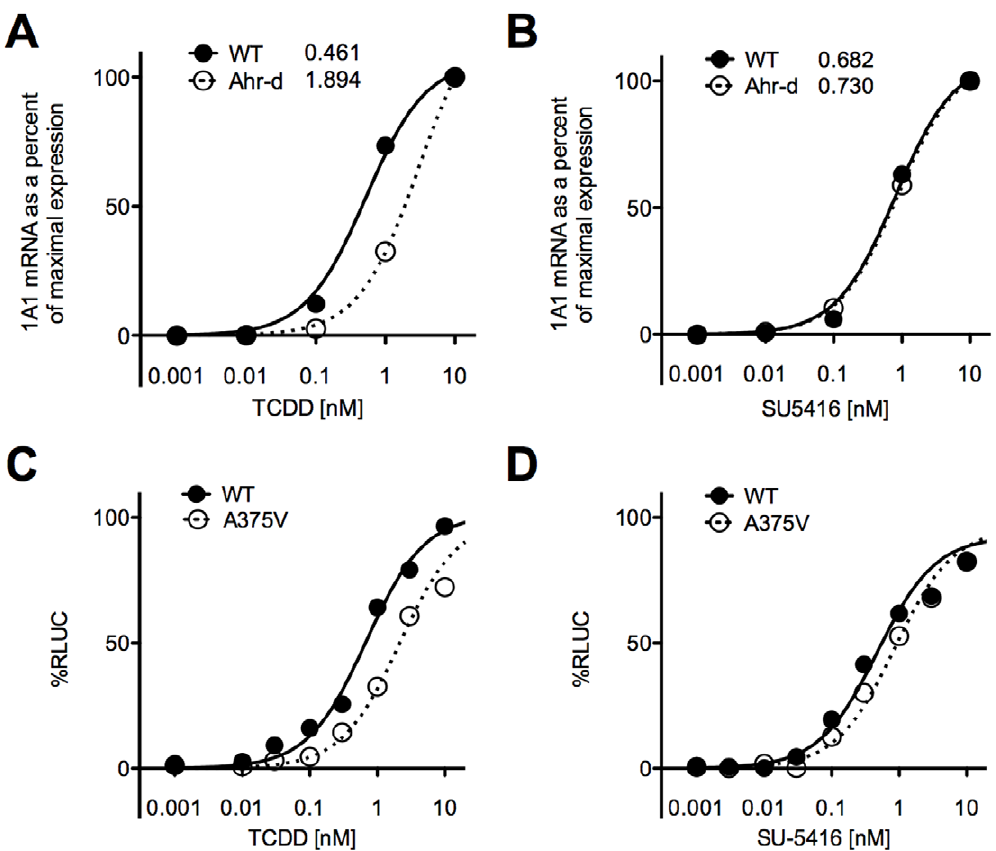
Figure 4. Splenocytes from wild-type and AHR d mice analyzed by qPCR for CYP1A1. Spleens from these mice were harvested and suspended in culture media, and exposed to titrating doses of A) TCDD B) SU5416. After 4 hours they were analyzed by qPCR for CYP1A1 analysis. The curves are normalized from 0 to 100% response. Each graph is representative of 3 independent experiments. C–D. Cells transfected with AHR containing a valine point-mutation show similar ED 50 to Cos-1 cells with AHR b isoform. Cos-1 cells were transfected with an AHR containing the same point mutation (valine for alanine) thought to be responsible for the low affinity of the AHR d isoform compared to AHR b , and compared to the wild- type AHR response. These cells also harbor a luciferase gene next to the DRE. C. Cos-1 cells were exposed to TCDD. D. Cos-1 cells were exposed to SU5416. The graphs represent normalized data from 0 response to 100% response. They are representative of 2 independent experiments.